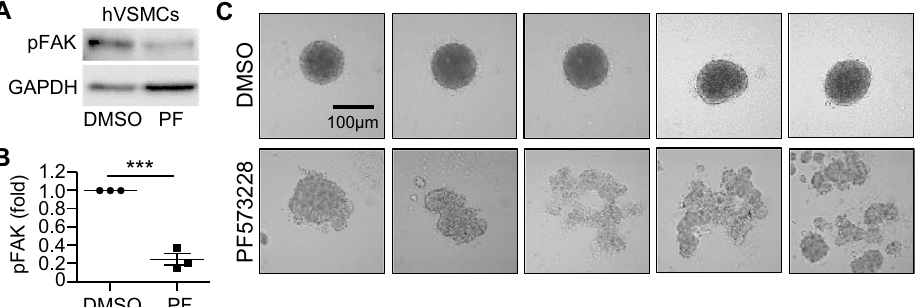
Figure 2. Inhibition of FAK phosphorylation differentially affects VSMC spheroid formation and morphology. Human VSMCs treated with FAK inhibitor (PF573228) or DMSO (vehicle control) in high-glucose DMEM containing 10% FBS were incubated for 24 h to generate human VSMC spheroids. Total cell lysates were immunoblotted ( A ) for phosphorylated FAK at Tyr397 (pFAK) and GAPDH. The bar graph displays the pFAK levels normalized to the DMSO control ( B ). ( C ) Cultures were imaged using an upright microscope. n = 3 ( A – B ) and n = 12 ( C ) biological replicates were used. ***p <